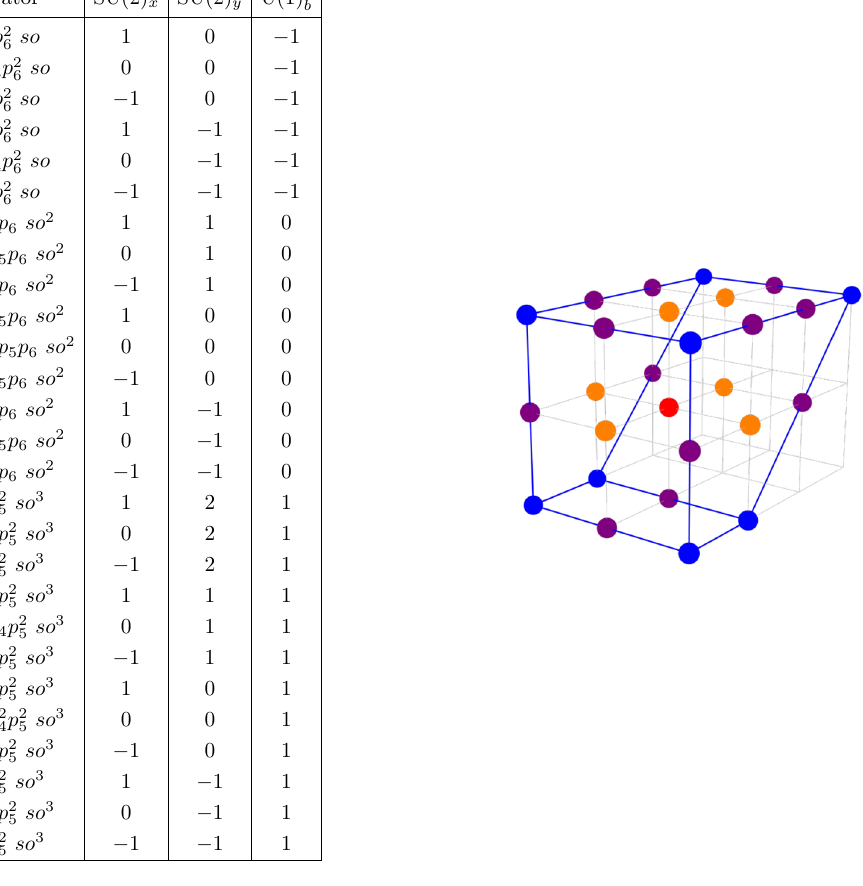
Table 44 . The generators and lattice of generators of the mesonic moduli space of Model 11 in terms of brick matchings with the corresponding flavor charges.